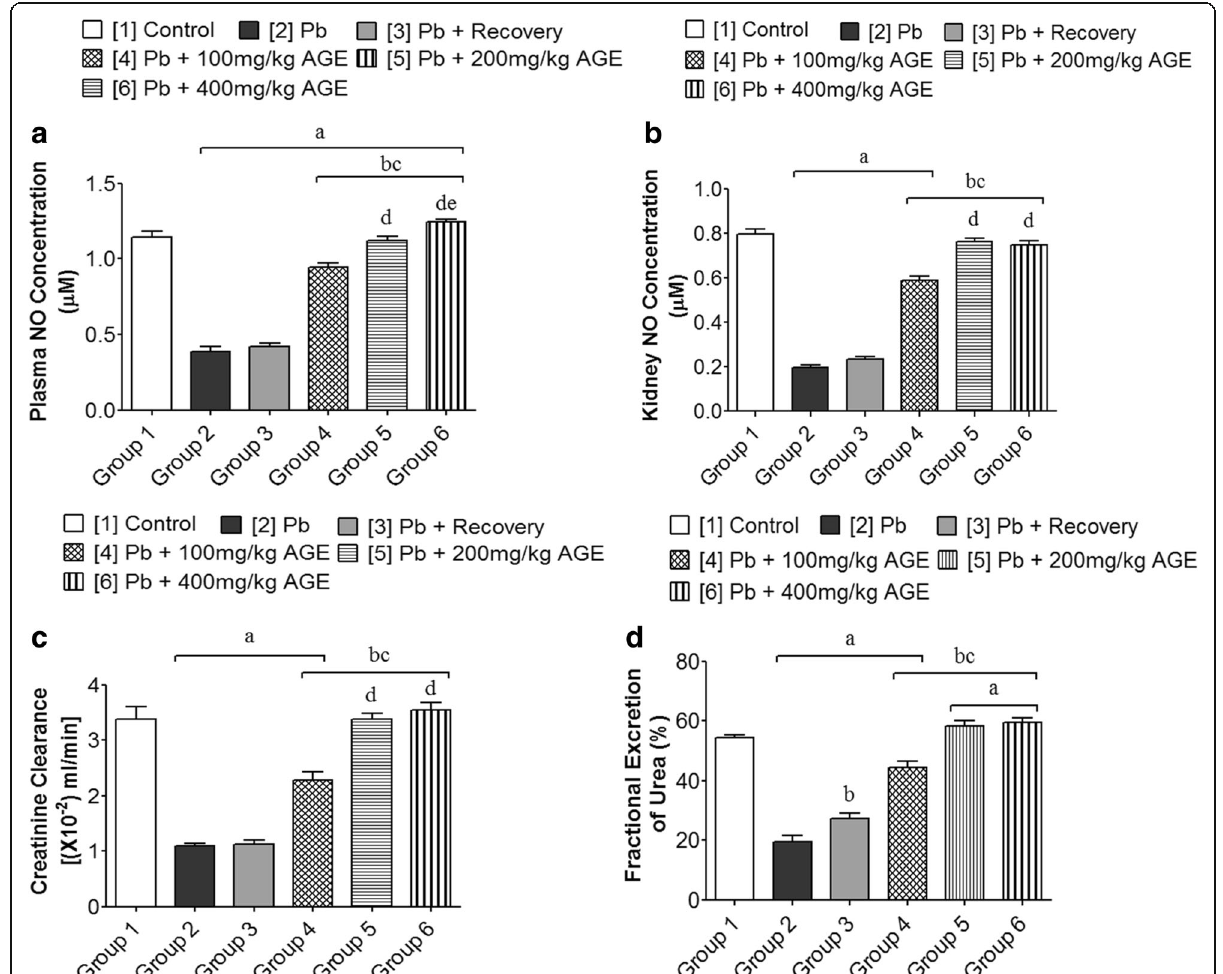
Fig. 2 Effects of AGE on plasma and kidney nitric oxide concentrations, creatinine clearance and fractional excretion of urea of Wistar rats with Pb-induced kidney injury. Each bar represents mean ± Standard Error of Mean (S.E.M.) at p < 0.05. a = significantly different from control group [1], b = significantly different from Pb group [2], c = significantly different from Pb + recovery group [3], d = significantly different from Pb + 100 mg/kg group [4], and e = significantly different from Pb + 200 mg/kg group [5]